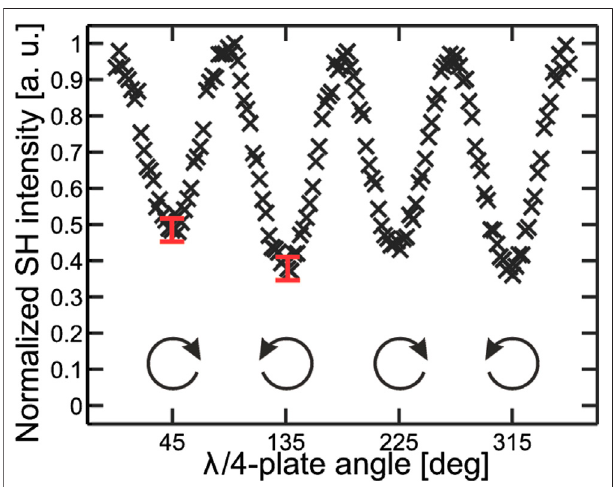
FIGURE10| MeasuredSHGresponsefromachiralthin fi lmofTHBQas a function of the rotation angle of the QWP. The angles 45 o , 135 o , 225 o , and 315 o correspond to CP with varying handedness. The measured SHG-PD response was 0.24. The fi gure and caption have been adapted with permissionfromHuttunenetal.,(2010),Copyright © 2010AmericanChemical